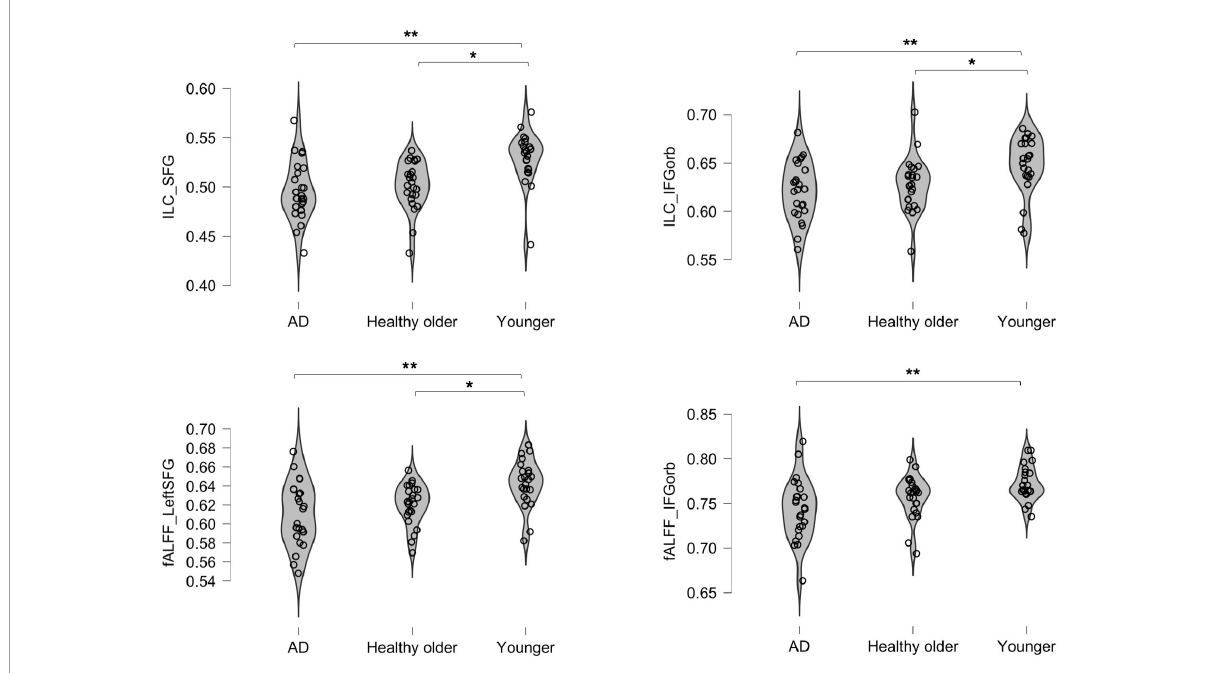
FIGURE1 Inter-group differences in integrated local correlation (ILC) and fALFF values. The y axis represents individual ILC and Fractional amplitude of low-frequency oscillation (fALFF) values. * p < 0.05; ** p <